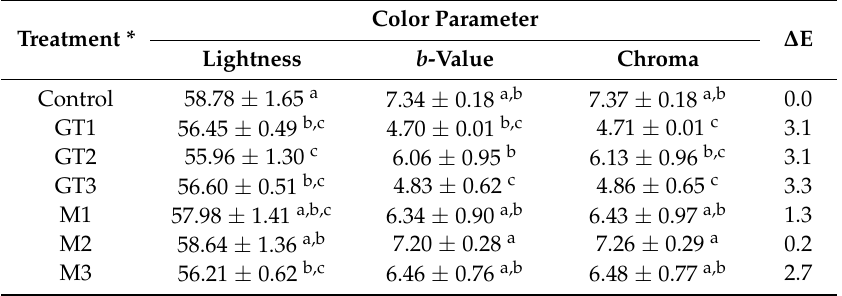
Table 2. Color parameters (mean ± sd) and the total color difference ( ∆ E) in brine-injected pork